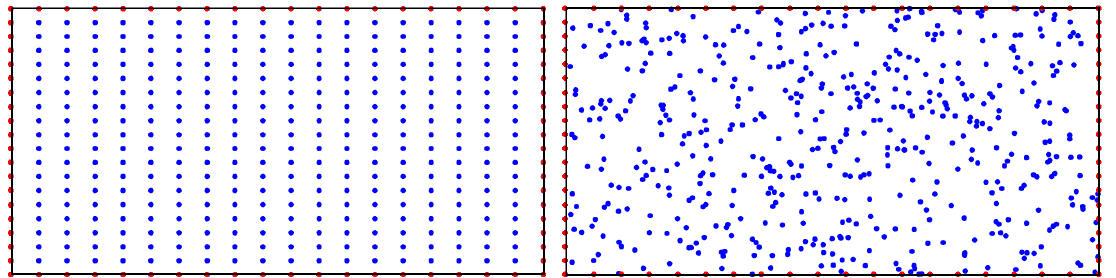
Figure 4. Uniform node set containing N = 400 versus non-uniform nodal domain containing N = 400 randomly spaced nodes.